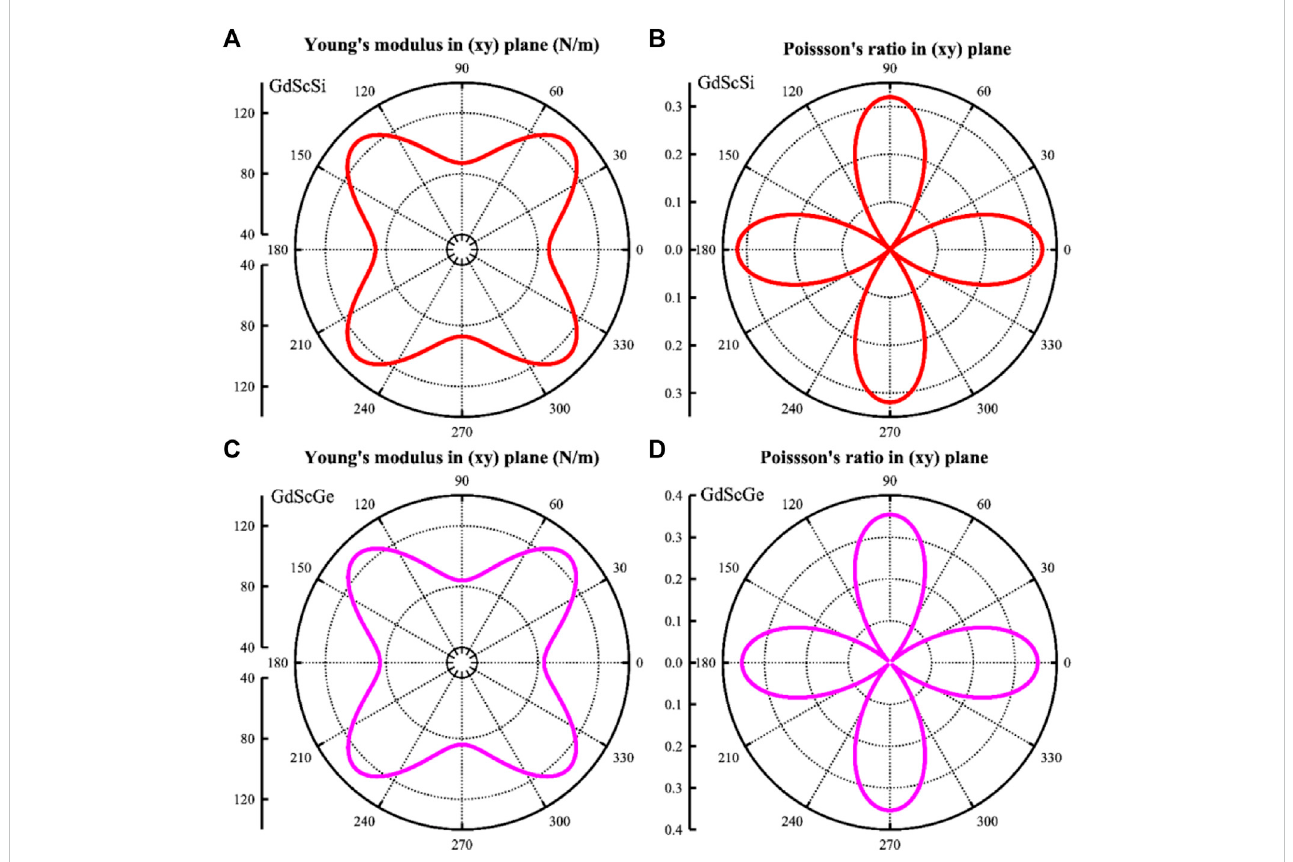
FIGURE 2 Calculated orientation-dependent (A) Poisson ’ s ratios and (B) Young ’ s moduli of the GdScSi monolayer (A, B) and the GdScGe (C, D)